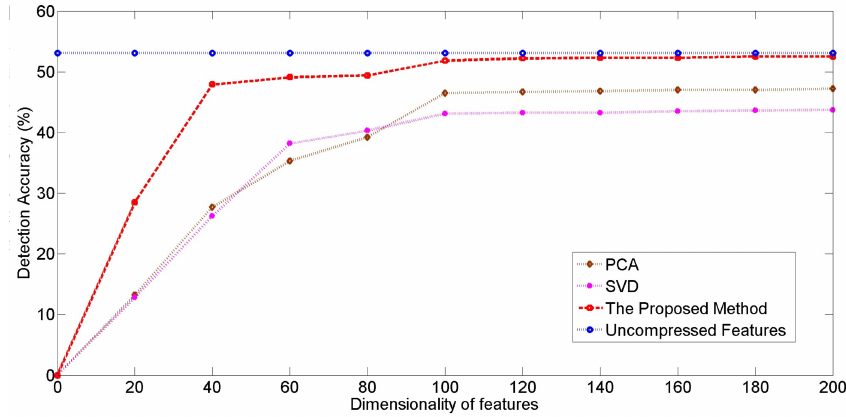
Figure 12. Illustration of the relationship between compressed dimensionality and detection accuracy.